Question: What caption would you write for this figure?
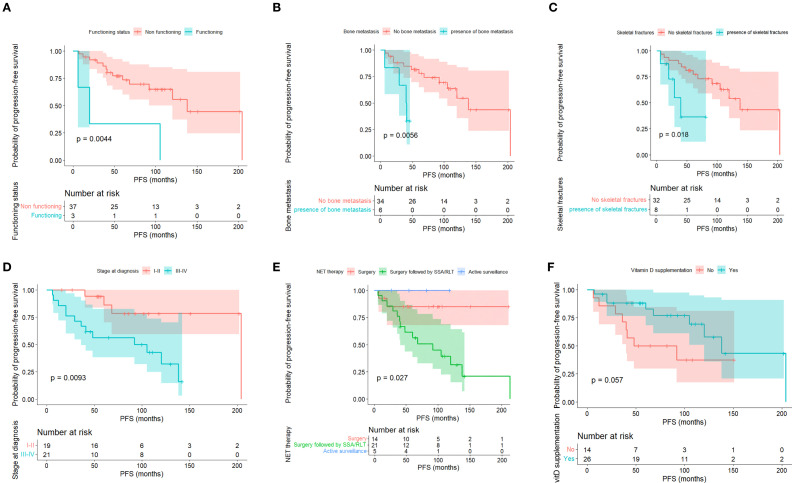
Answer: Kaplan–Meier curves for progression-free survival (PFS) according to (A) NET (neuroendocrine tumor) functioning status, (B) bone metastasis, (C) skeletal fractures, (D) NET stage at diagnosis (I-II vs III-IV), (E) NET therapy, (F) vitamin D supplementation. Statistical comparisons are reported as log-rank p-values.